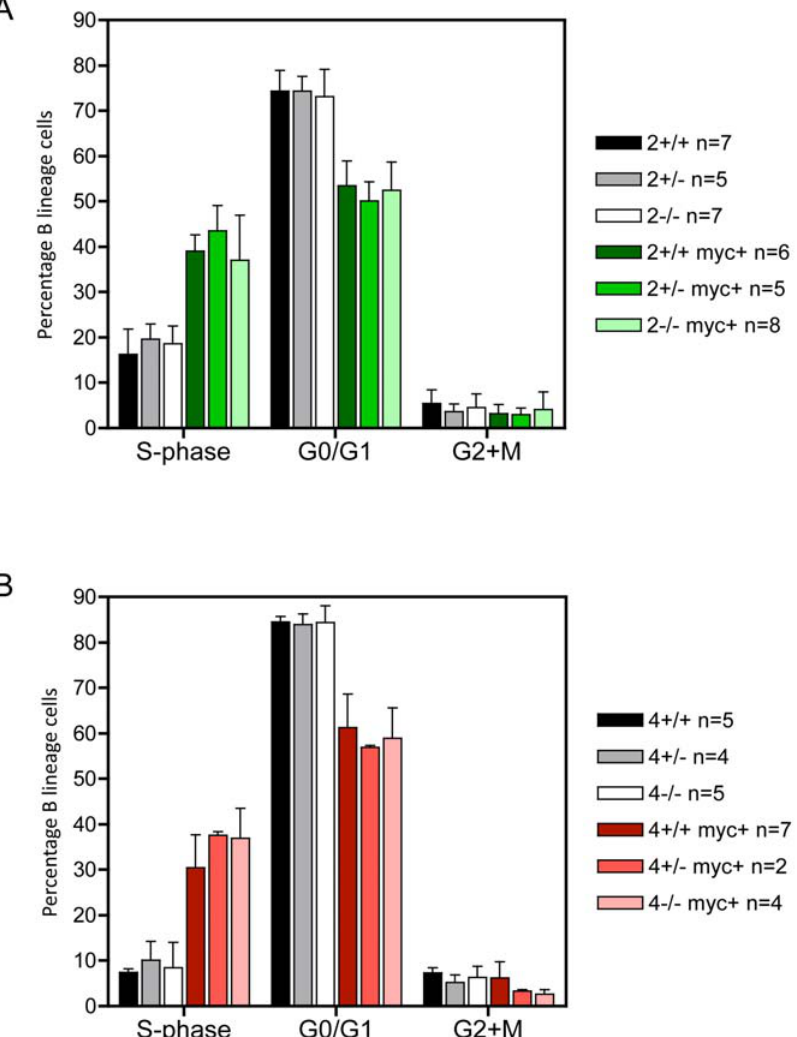
Figure 2. The cell cycle distribution of pretumorous B lineage cells is not altered by E2F2 or E2F4 status. (A) The cell cycle distribution of bone marrow B lineage cells (B220 + CD19 + ) from pretumorous E2F2 cohort mice. The error bars indicate standard deviation. (B) The cell cycle distribution of bone marrow B lineage cells (B220 + CD19 + ) from pretumorous E2F4 cohort mice. The error bars indicate standard deviation.